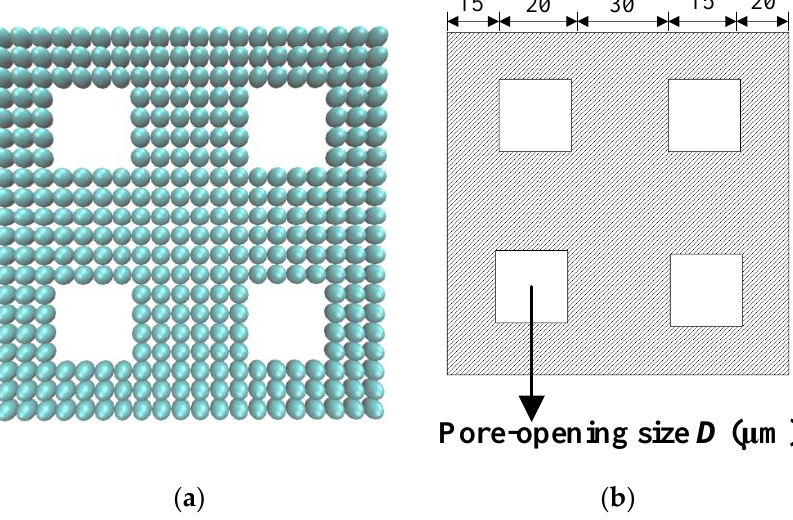
Figure 5. Numerical modeling on PVD membrane: ( a ) DEM modeling on PVD membrane, ( b ) schematic plan view on the membrane.